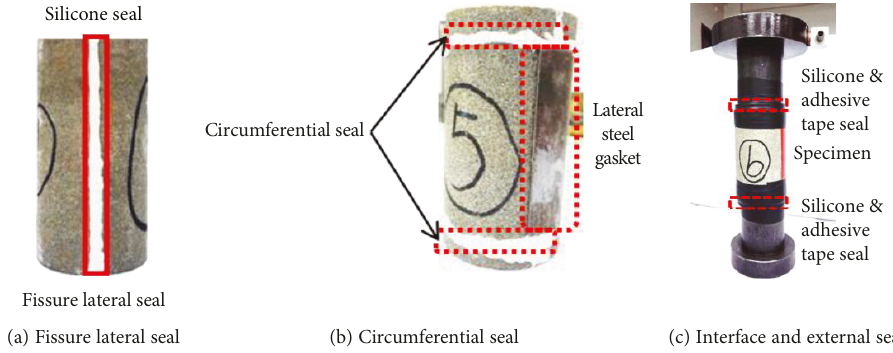
Figure 3: Treatment method of specimens for unidirectional fi ssure seepage.